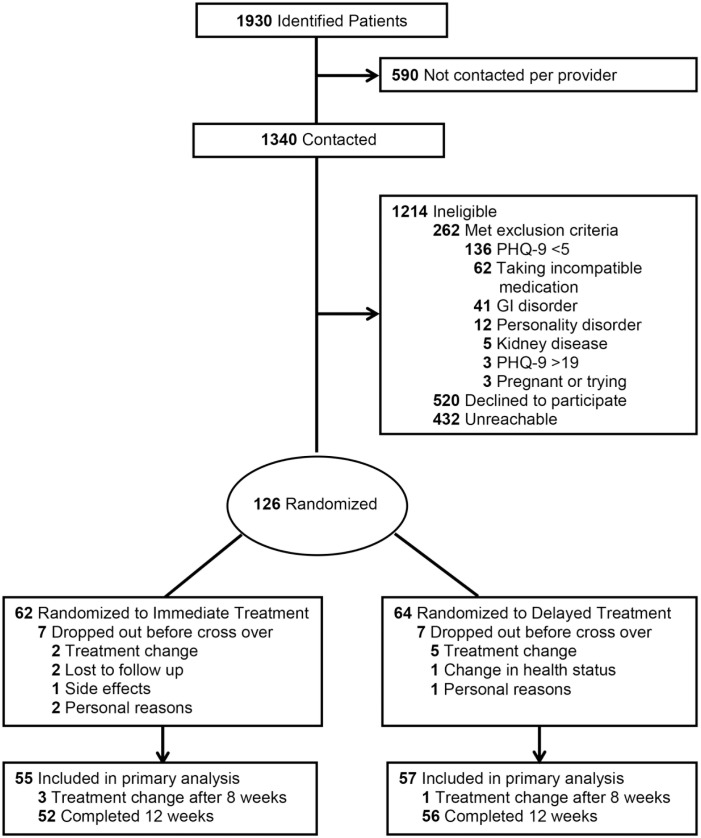
Consort diagram.